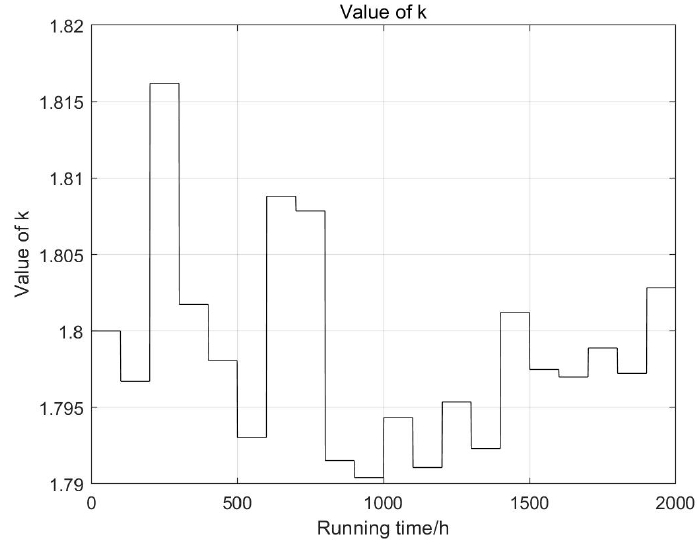
Figure 10. Changes in environmental factor.